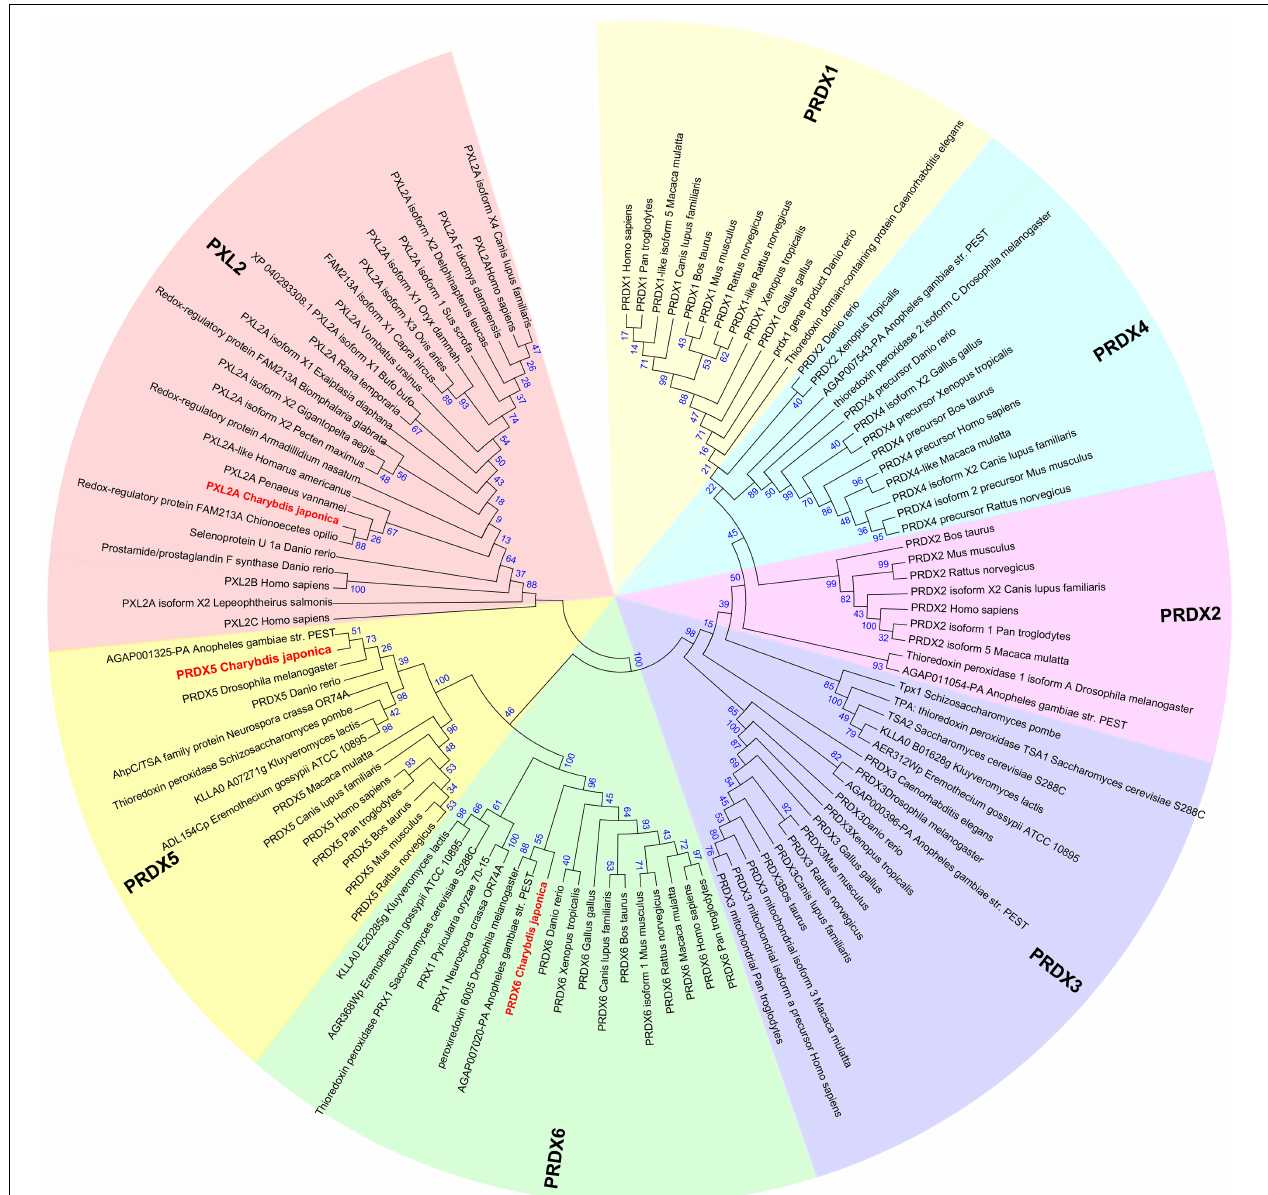
FIGURE 6 | Evolutionary relationships of the Peroxiredoxin